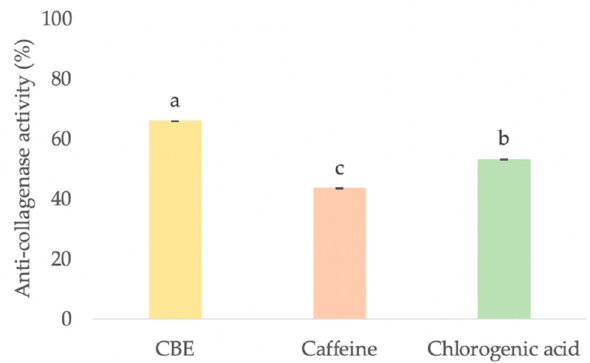
Figure 5. The superoxide dismutase ( A ), nitric oxide inhibition ( B ), and anti-collagenase ( C ) activities of CBE, caffeine, and chlorogenic acid on HDF. Data with different lower-case letters (a, b and c) indicate significant differences ( p < 0.05) between samples.